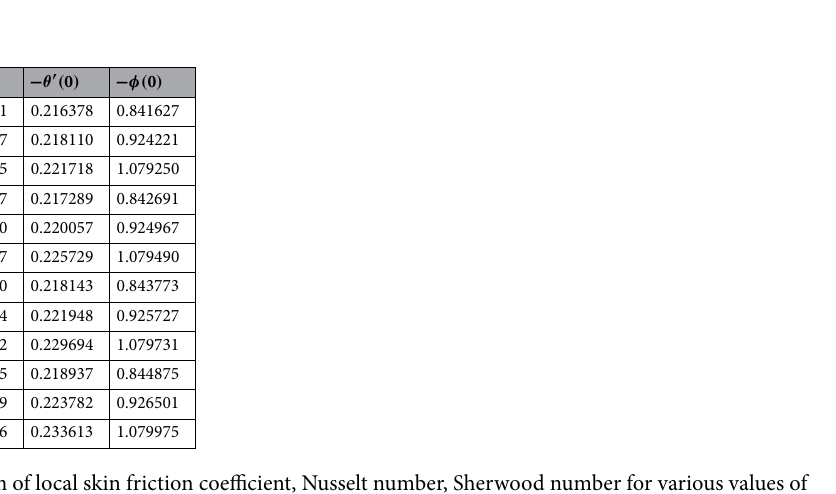
Table 3. Variation of local skin friction coefficient, Nusselt number, Sherwood number for various values of Du for n = 1, 2, 3.